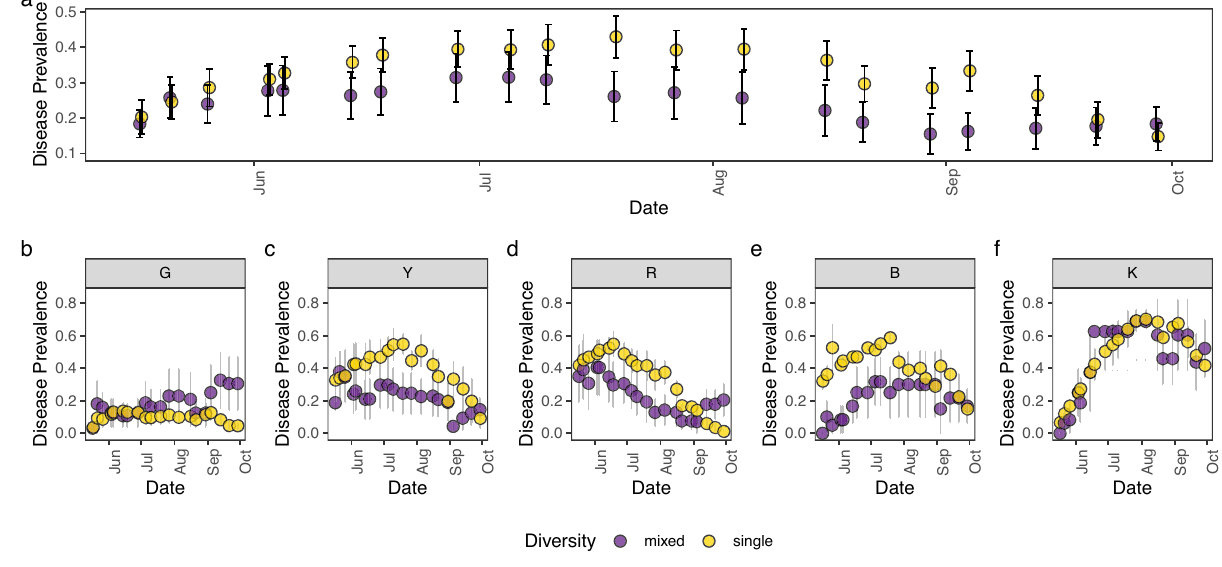
Figure 2. Prevalence of disease Mean ± standard error (SE) of disease prevalence across ( a ) all frames, and by genotype ( b ) “G” ( c ) “Y”, ( d ) “R”, ( e ) “B”, ( f ) “K”. Point colors represent mixed (purple) and single (yellow) genotype treatments. Genotype G (plot b ) and Genotypes Y, R, and B (plots c – e ) are the resistant and vulnerable genotypes, respectively. Genotype K (plot f ) is highly